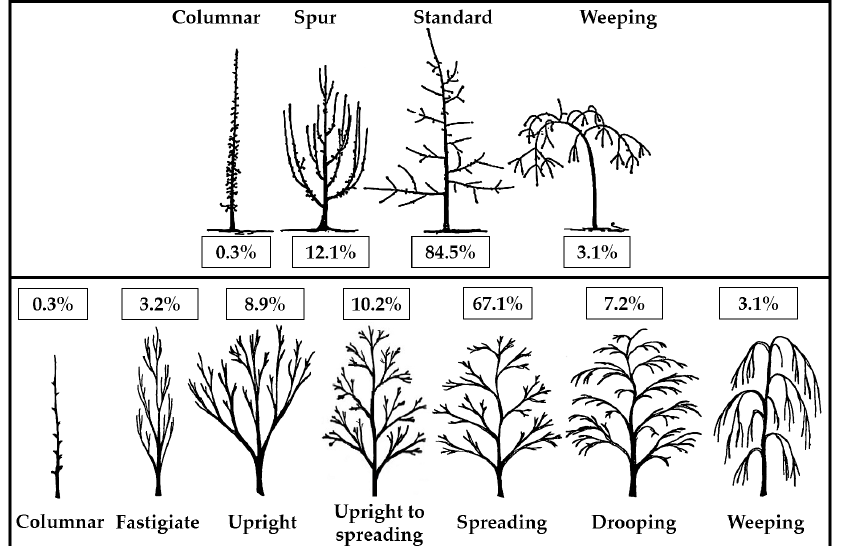
Figure 1. Distribution of F 1 hybrids (%) in tree architectural ideotypes (tree growth or habitus) according to the classification of Lespinasse et al. ( top ) [40] and UPOV ( bottom ; adapted both from edible and ornamental cultivars) [41,42].